Question: State the chart type depicted above.
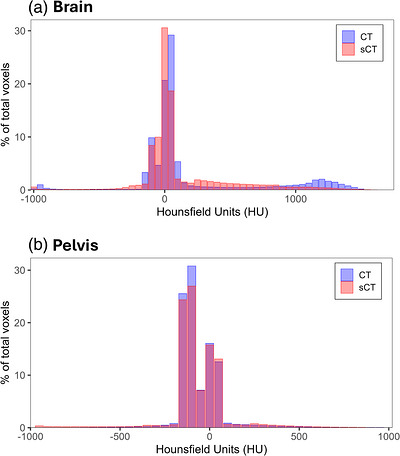
Answer: histogram